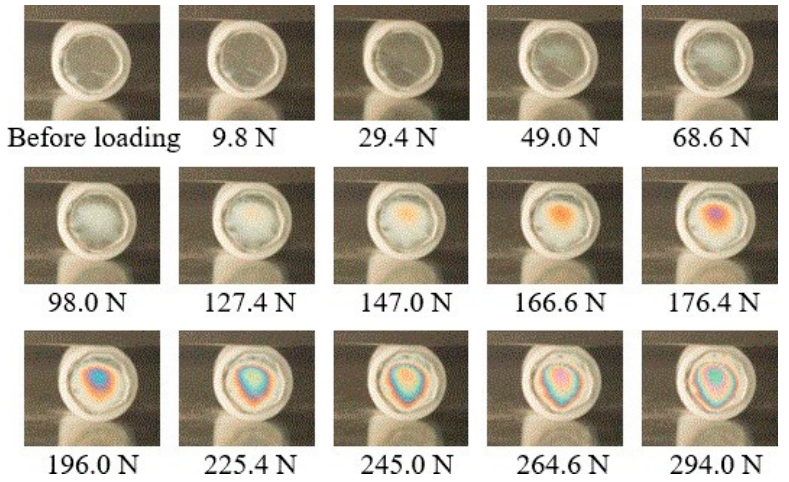
Figure 2. Changes in fringe order patterns of a single particle according to particle force (N). From Park and Jung [21].